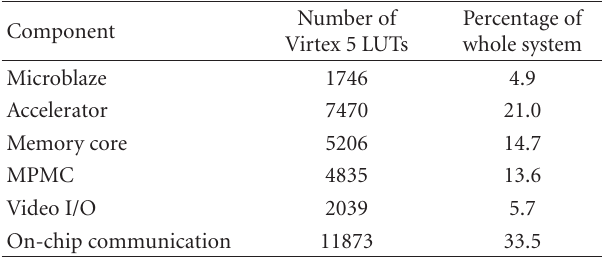
Table 2: Resource utilization of the individual